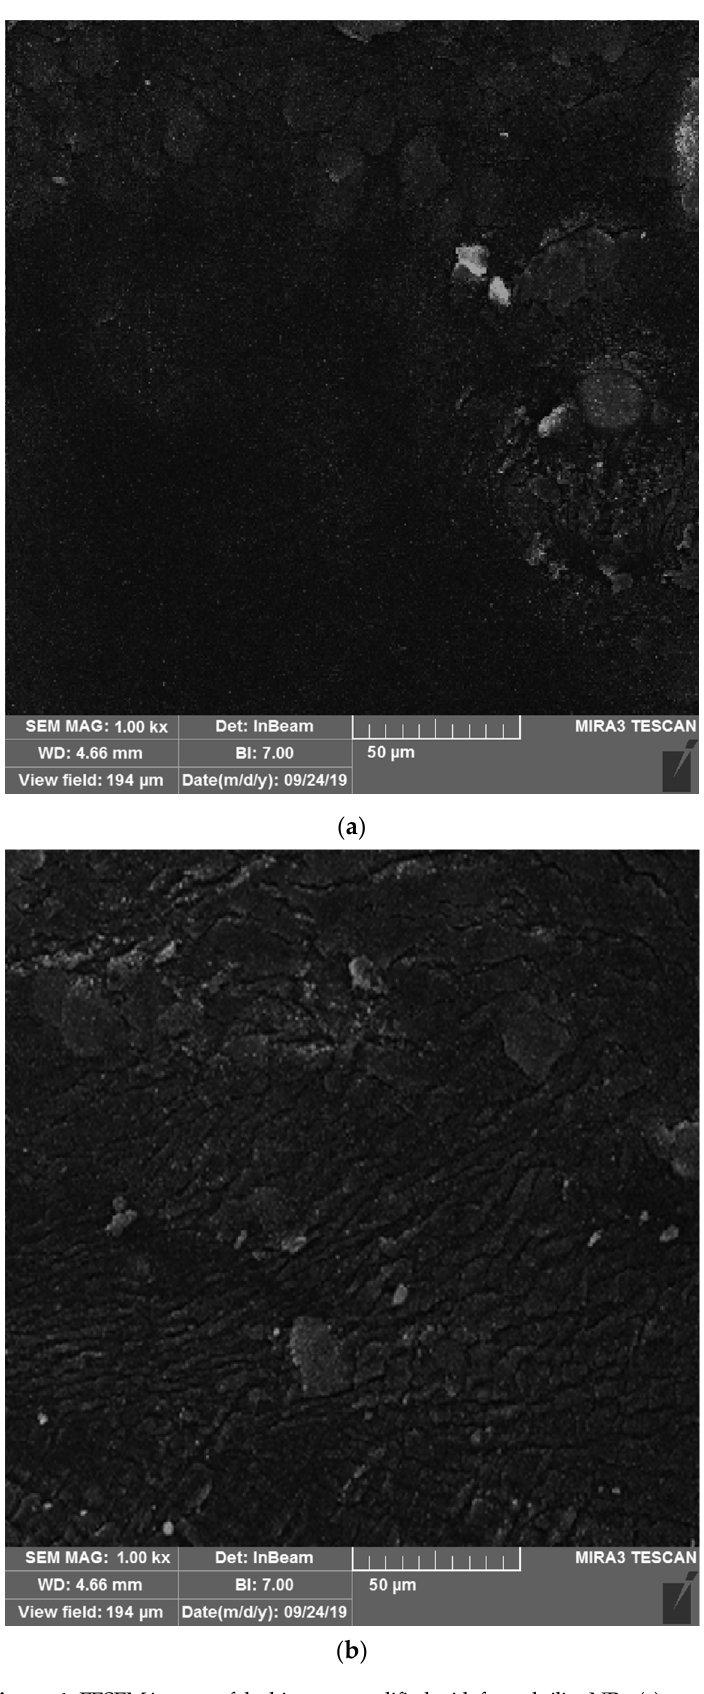
Figure 4. FESEM images of the bitumen modified with fumed silica NPs: ( a ) unaged and ( b ) aged Figure 4. FESEMimagesofthebitumenmodifiedwithfumedsilicaNPs: ( a )unagedand( b in laboratory.